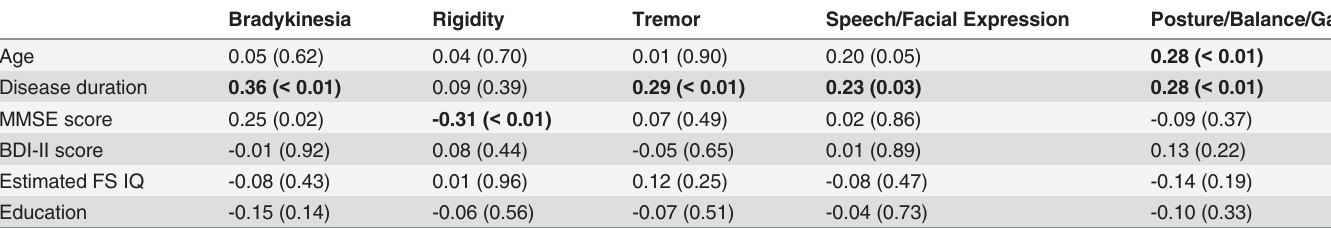
Statistically signi fi cant relationships are shown in bold font.